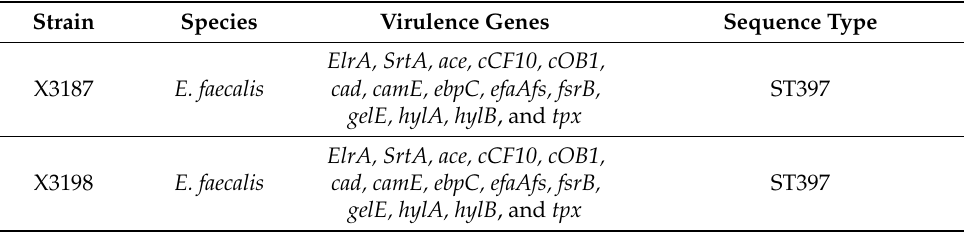
Table 5. Virulence genes and sequence types detected in the BP+ E. faecalis and E. faecium isolates of poultry origin by